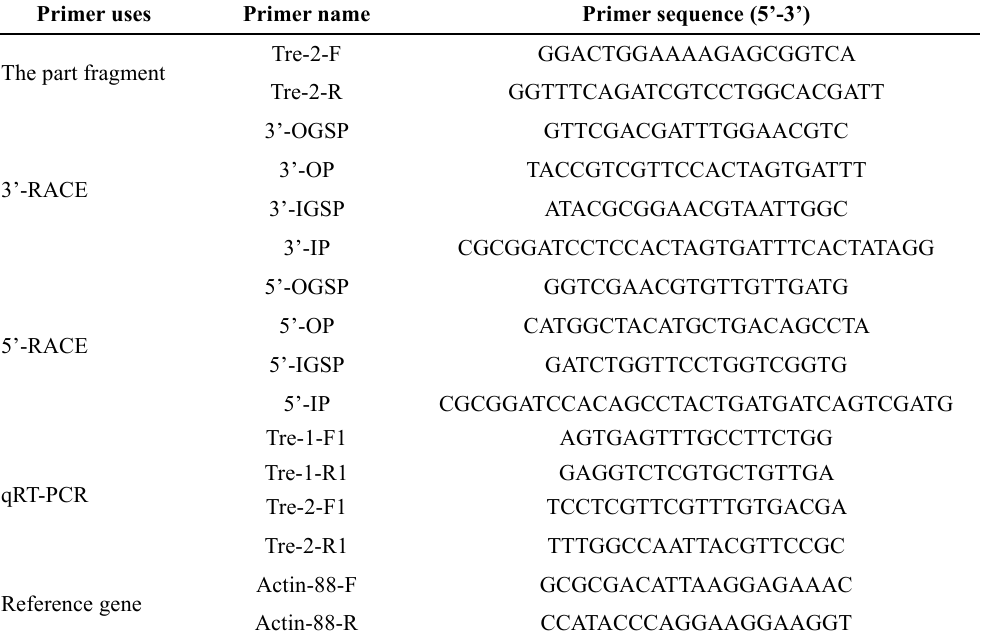
Table 1 . Primers used in this